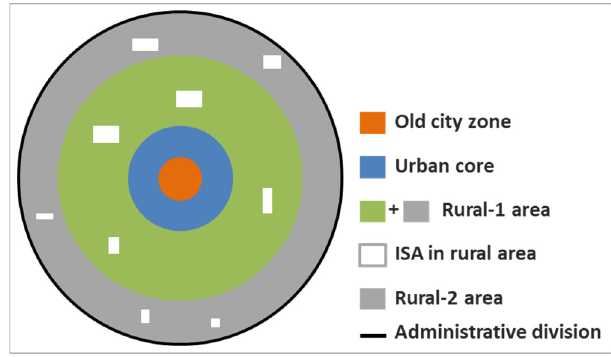
Figure 3. Spatial location for the research regions.